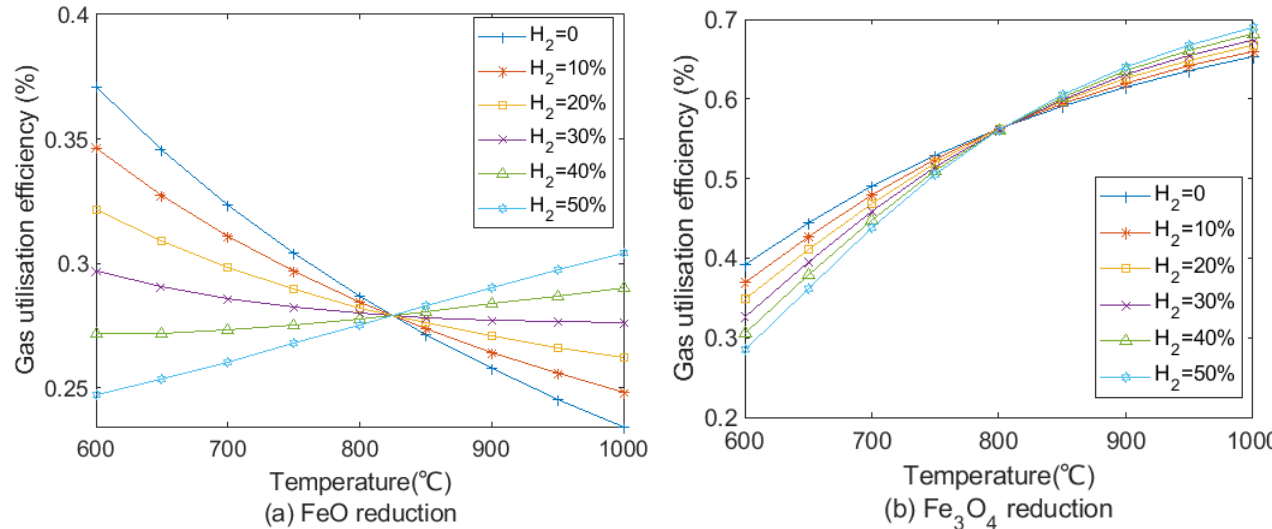
Figure 5. Gas utilisation efficiency at different H 2 /CO ratio with temperature in ( a ) FeO and ( b ) Fe 3 O 4 reductions.